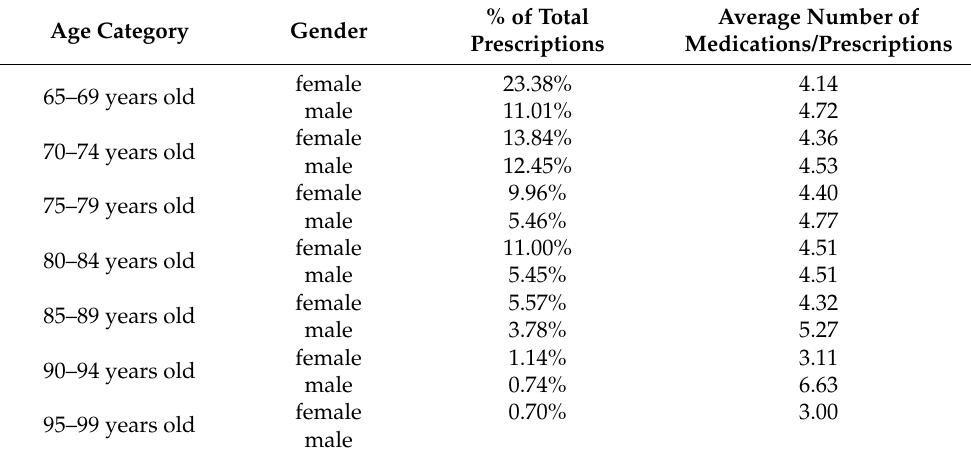
Table 2. The average number of medicine/prescriptions based on